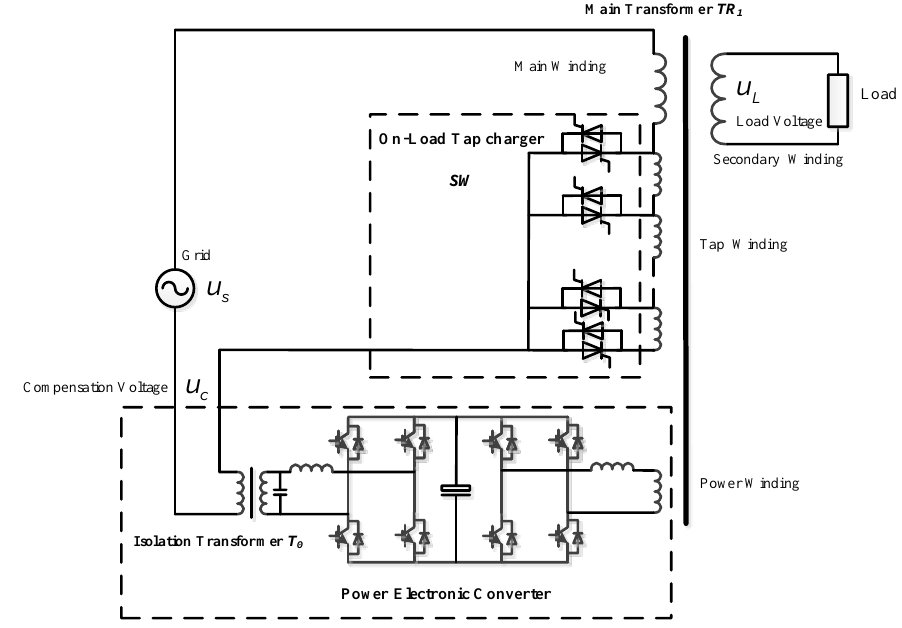
Figure 2. Single phase schematic diagram of flexible on-load voltage regulator.